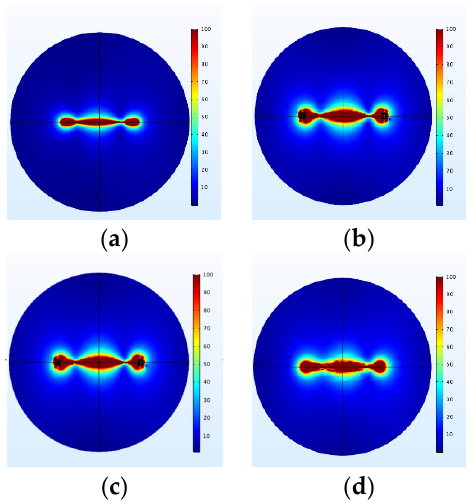
Figure 9. Electric field modulus of four kinds of transfer structures: ( a ) Linear; ( b ) Conical; ( c ) Cylindrical; ( d ) Planar.